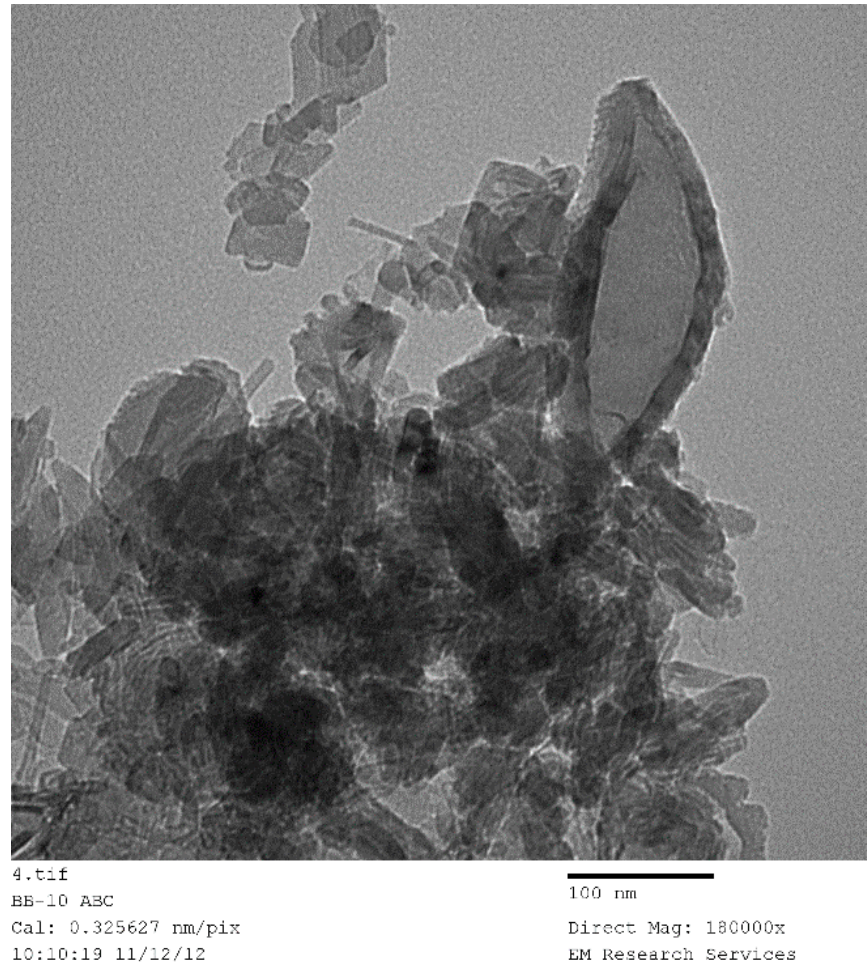
Figure 21. Transmission electron microscopy image of silica supported cobalt catalyst produced through microwave irradiation followed by heat treatment at 600 °C and then reduced in a hydrogen environment at 550 °C. Sample is coded as Co/Si = 1/4 Mw ‐ ABC. Scale bar = 100 nm.